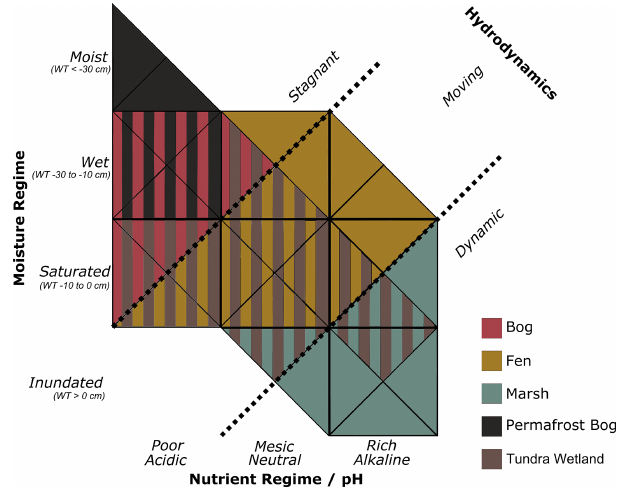
Figure 1. Descriptions of wetland classes in BAWLD as distin- guished based on the moisture regime, the nutrient and pH regime, hydrodynamics, and the presence/absence of